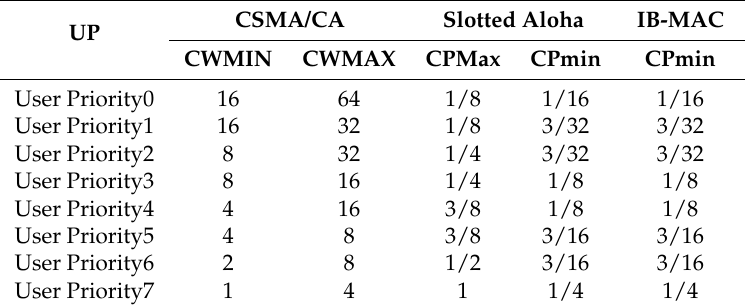
Table 3. Probability and contention window size depending on user